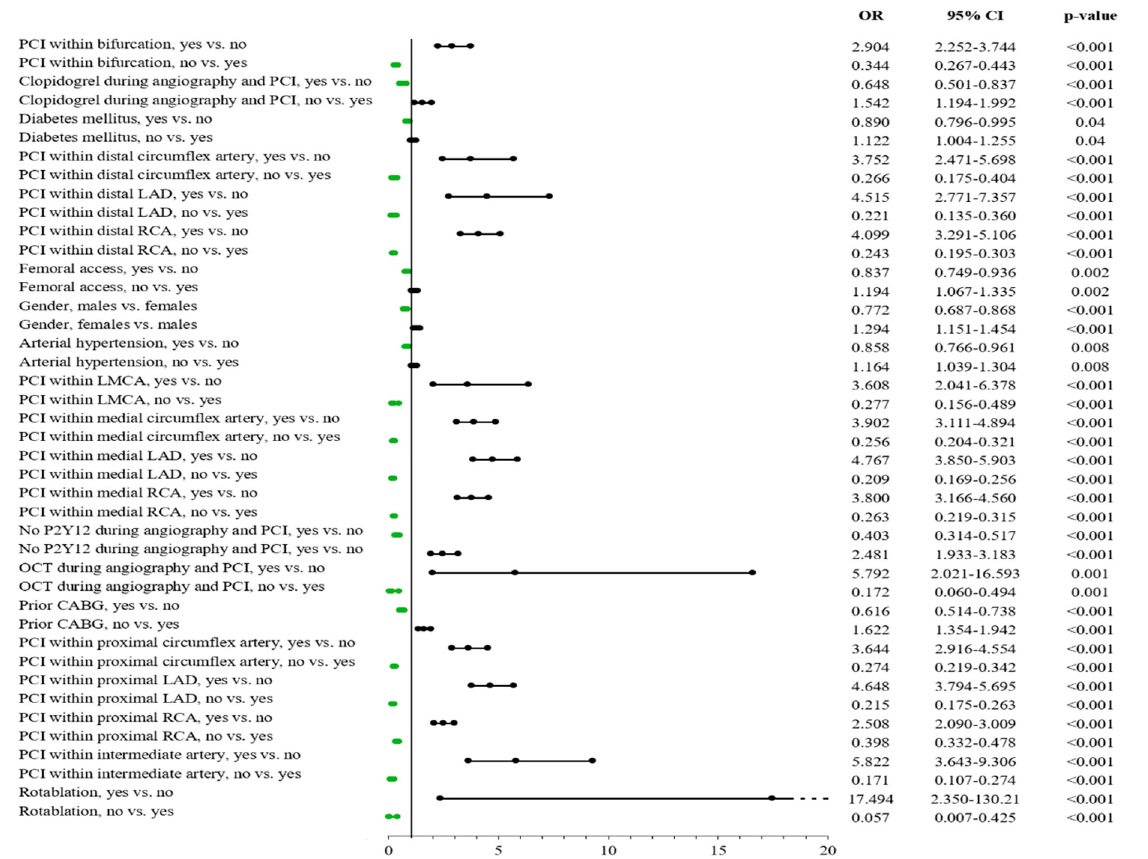
Figure 4. Predictors of procedural success assessed as TIMI flow grade 3 after PCI. LAD: left anterior descending artery; LMCA: left main coronary artery; OCT: optical coherence tomography; PCI: percutaneous coronary intervention; RCA: right coronary artery.